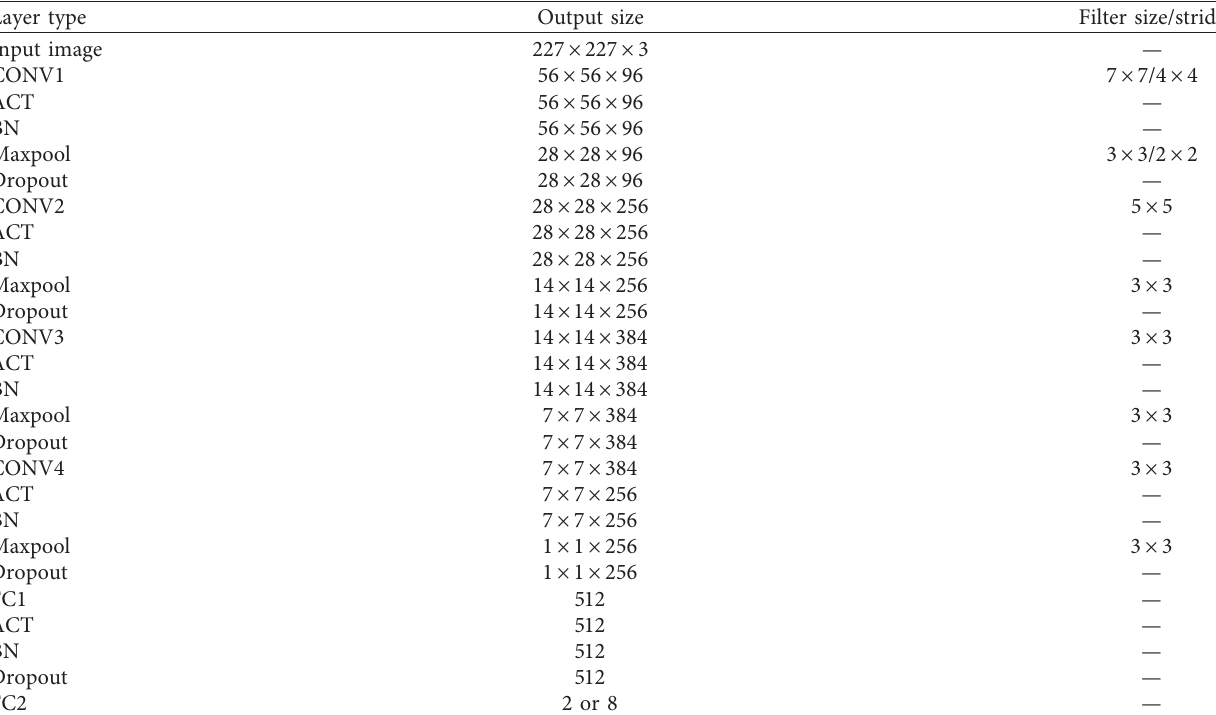
Table 1: The details of CNN architecture for the proposed